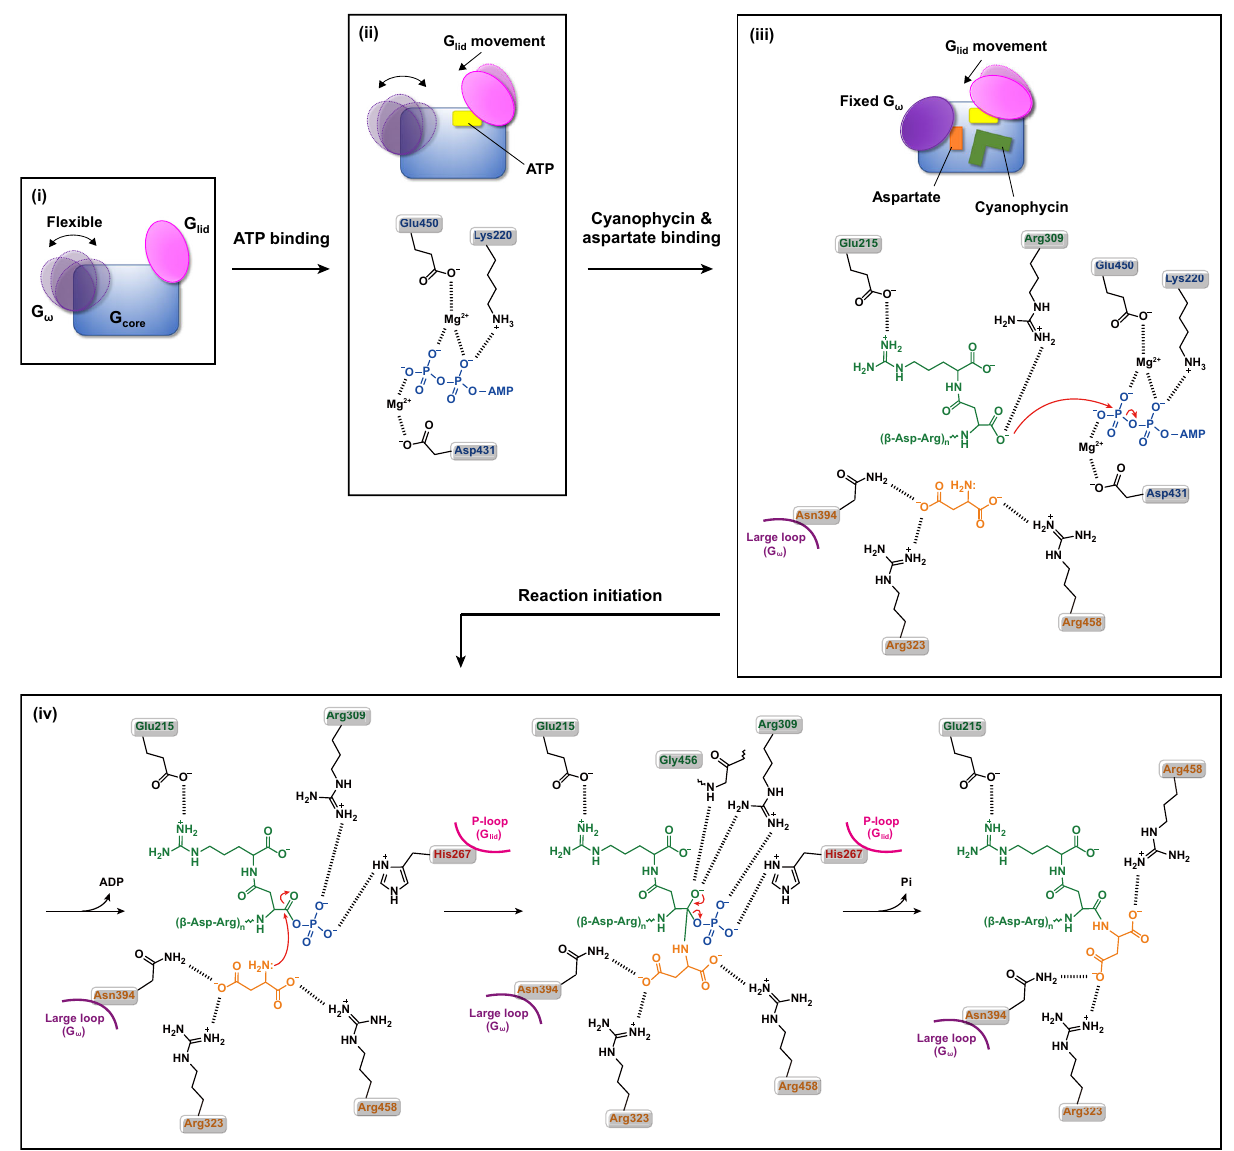
Fig. 5 | Schematic diagram of the catalytic reaction for aspartate addition to the C-terminal backbone carboxy group of cyanophycin. (i) G domain from a protomer in the apo state. Three modules, G core , G lid , and G ω , are shown in blue, pink,and purple, respectively. (ii) ATP-bound state. The chemical structureof ATP is depicted as AMP diphosphate. (iii)Substrate-bound state. The orientationof G lid further changes compared to the ATP-bound state. (iv) Feasible catalytic